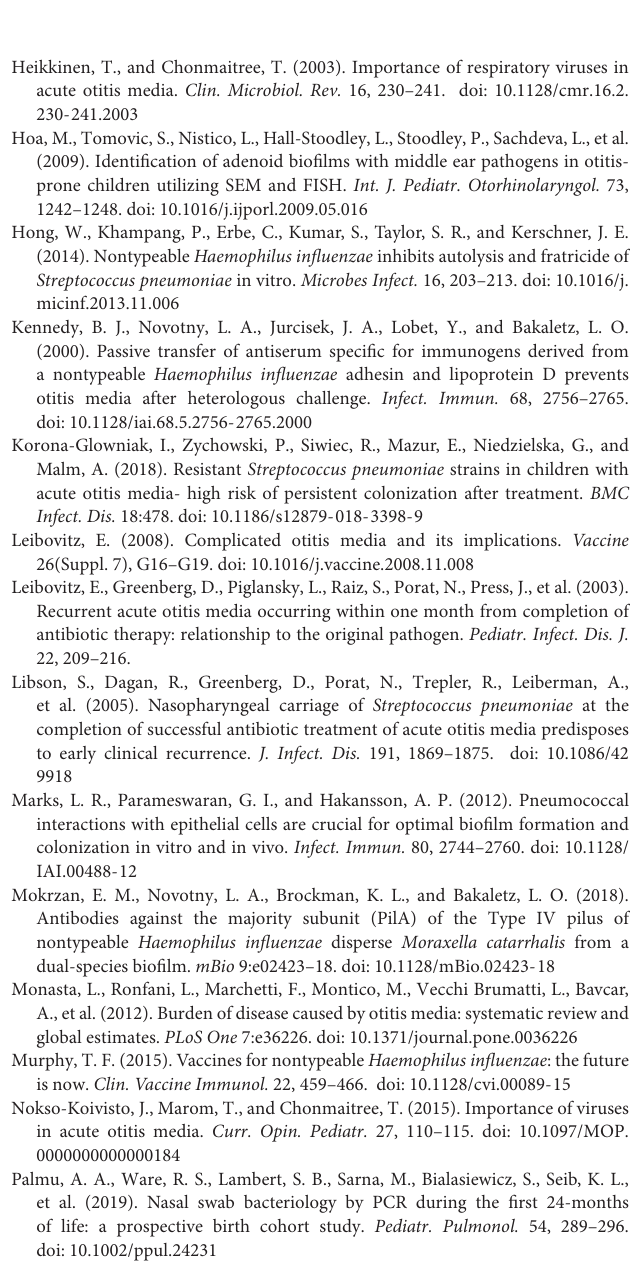
FIGURE S1 | A 48 h survival assessment. Bacterial species were statistically analyzed under each polymicrobial growth condition as compared to the monomicrobial control. Bars represent the mean and SD of minimally three independent assays. (A) NTHi, (B) S. pneumoniae , and (C) M. catarrhalis growth conditions were log transformed and analysis was completed using a student’s t -test or a Mann–Whitney test based on the Shapiro–Wilk test for normality. P -value of < 0.05 denoted ∗ , < 0.01 denoted ∗∗ , and < 0.001 denoted ∗∗∗